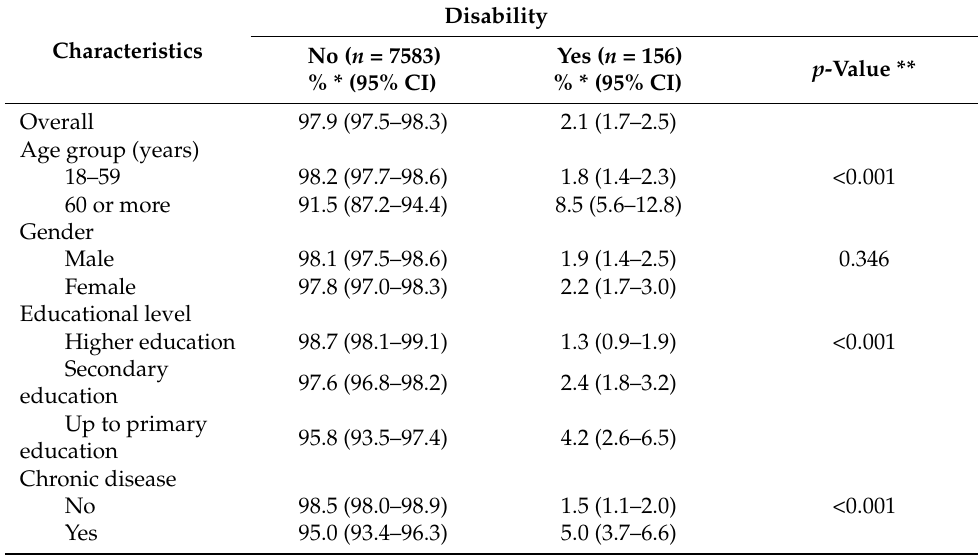
Table 3. Frequency of disability among Venezuelan migrants and refugees by background character- istics, ENPOVE